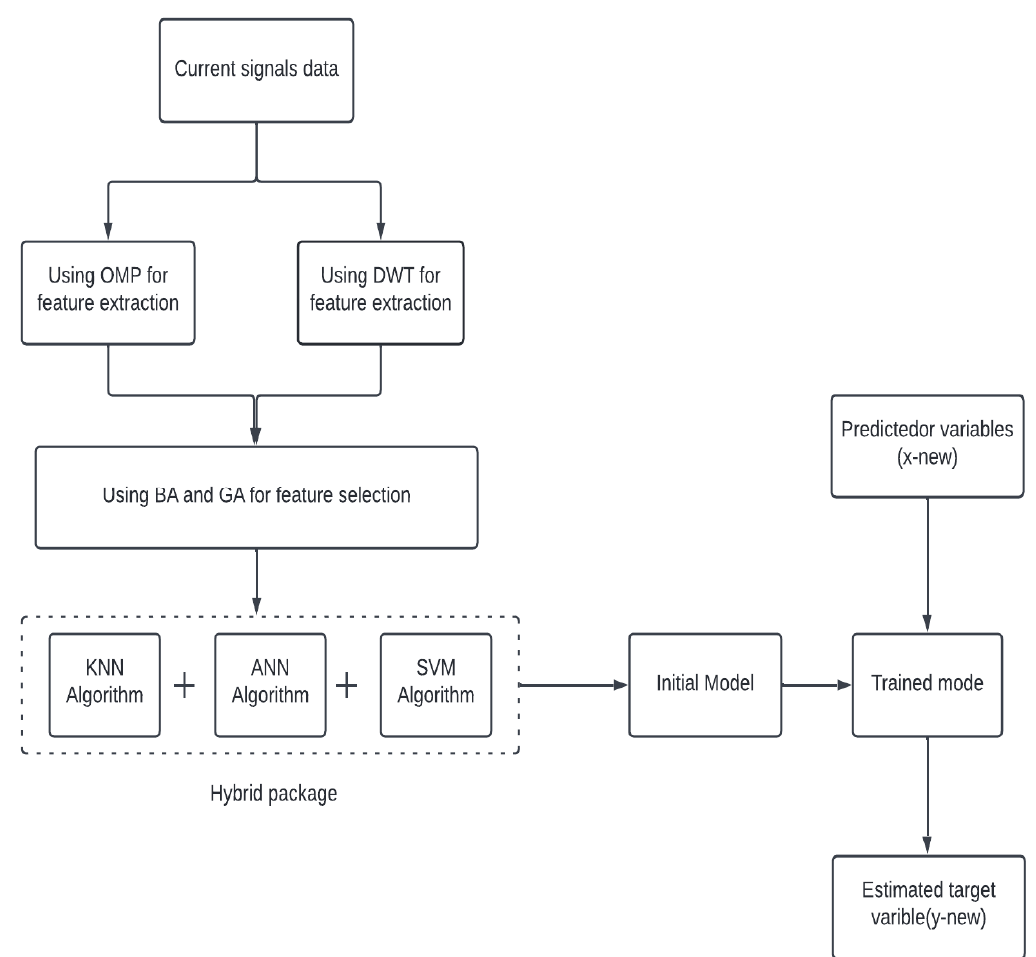
Figure 8. Flow chart for proposal method.